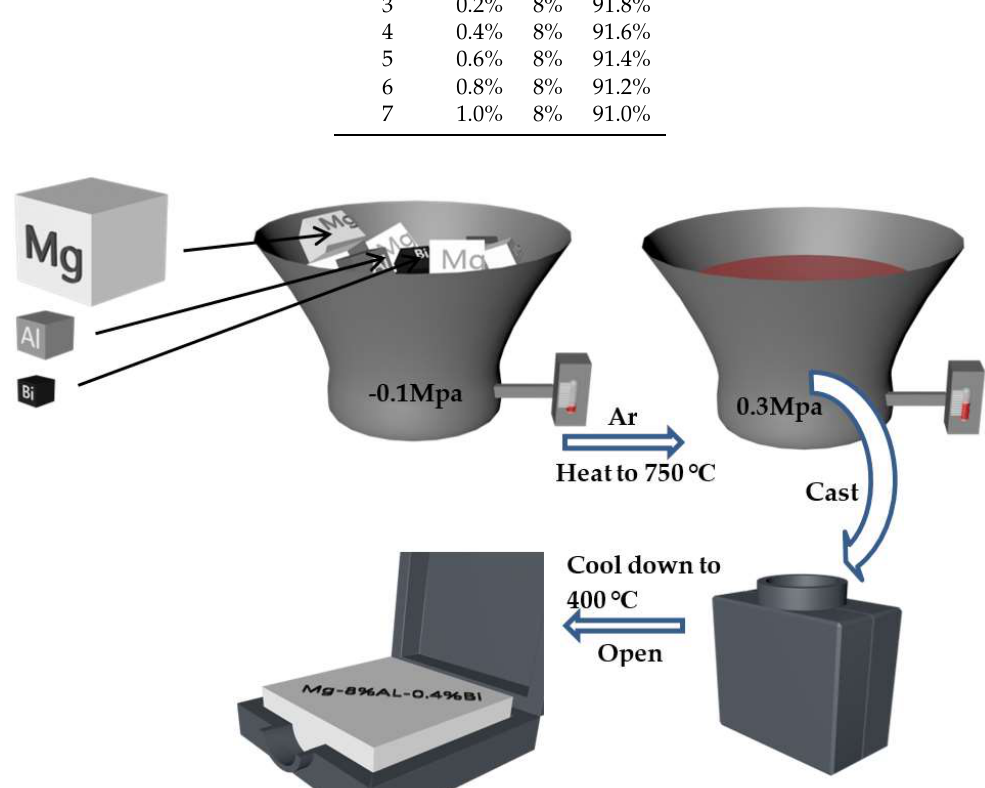
Figure 1. Mg–8%Al–0.4Bi alloy preparation process